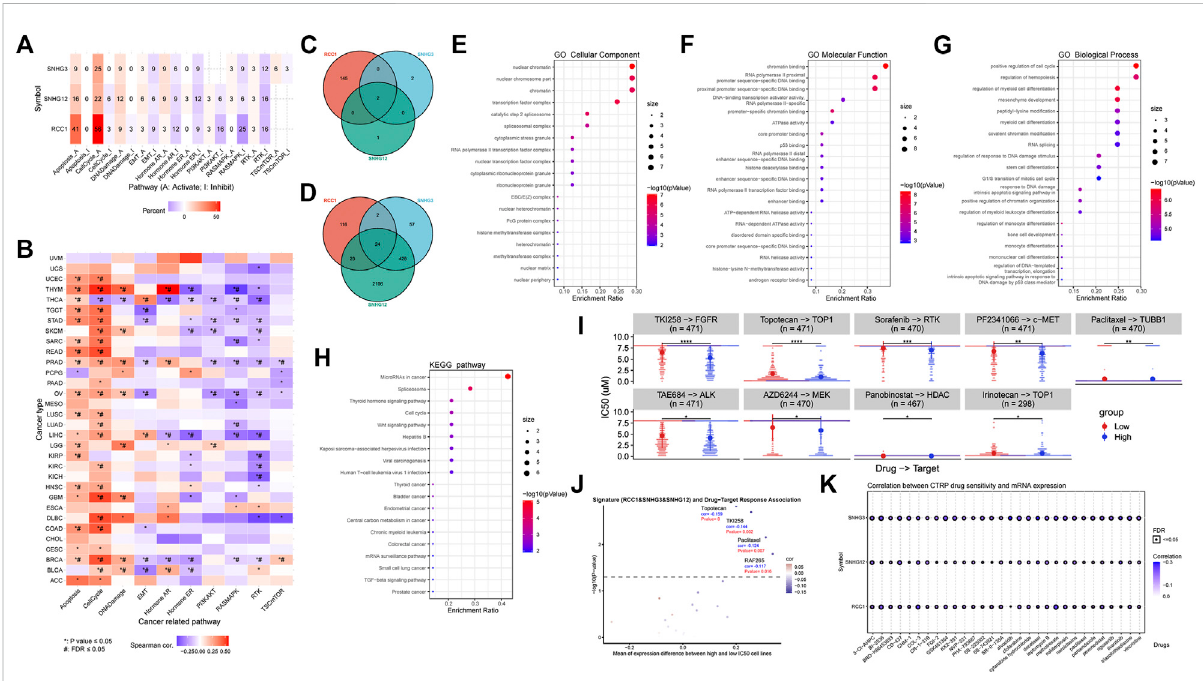
FIGURE 9 RCC1/SNHG3/SNHG12 is involved in cell cycle apoptosis regulation. (A,B) RCC1/SNHG3/SNHG12 as a single gene or gene set level analysis for expression and pathway activity. Numbers represent the percentage of cancers in which speci fi c gene ’ s mRNA expression has a potential effect on pathway activity. (C,D) Intersection analysis of the RCC1/SNHG3/SNHG12interacted or correlated genes. 24 related genes were identi fi ed in the latter. (E – H) GO and KEGG analysis of 24 related genes. (I,J) RCC1/SNHG3/SNHG12 as a signature for drug-target response difference and association in pan-cancer. (K) Correlation between CTRP drug sensitivity and mRNA